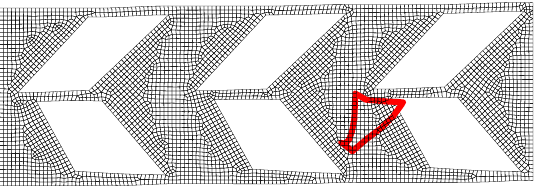
Figure 7. Three-unit finite element result showing the optimised chamber designs. The red line shows the enclosed area, which was maximised during the optimisation. For the three-element method, the midpoint of the right-hand side of the middle element is used as the tip to avoid the bulging of the tip having too large of an impact on the optimisation.